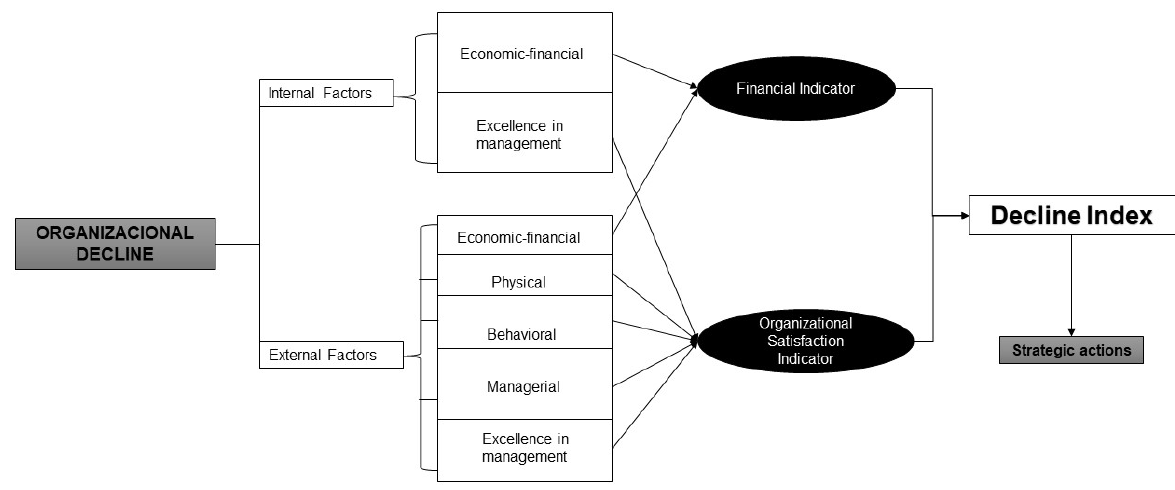
Figure 2. Proposal of theoretical model of organizational